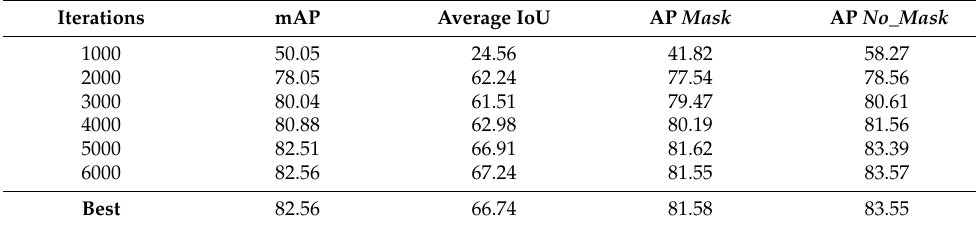
Table 6. Performance of YOLOv4-tiny.